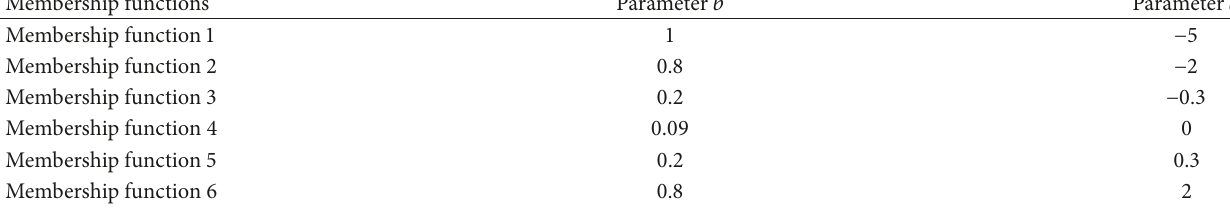
Table 1: Fuzzy parameters.